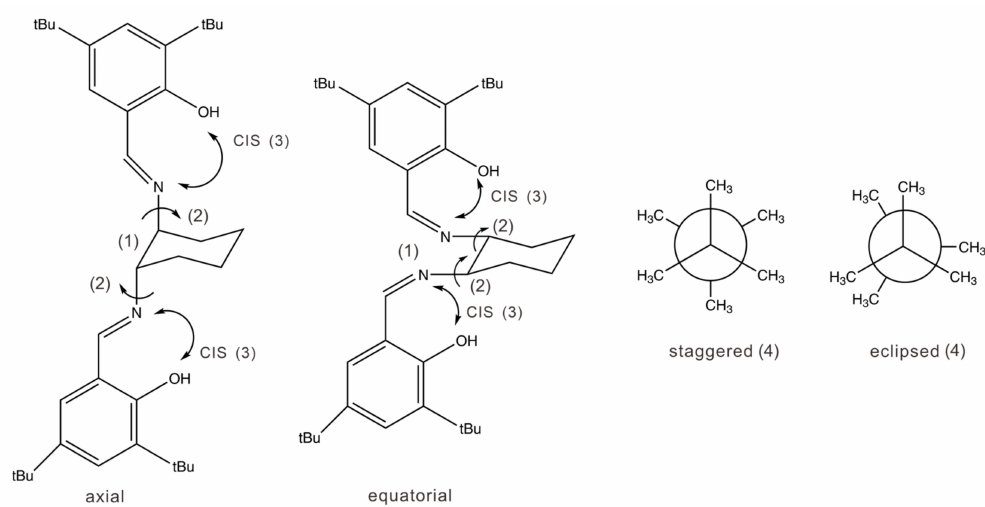
Figure 1. Possible conformations of salen-chxn: (1) the axial and equatorial conformations at cyclohex- ane; (2) the rotatable N-C hexane bonds are indicated by small arrows; (3) the OH orientation direction pointing to N=C (shown) or away (not shown); (4) the subtle staggered and eclipsed conformations of the tBu groups are also shown on the right side. The eclipsed CH 3 groups are offset slightly for easy viewing. The tBu groups of the two aromatic branches can take on the staggered–staggered, staggered–eclipsed, and eclipsed–eclipsed conformations.